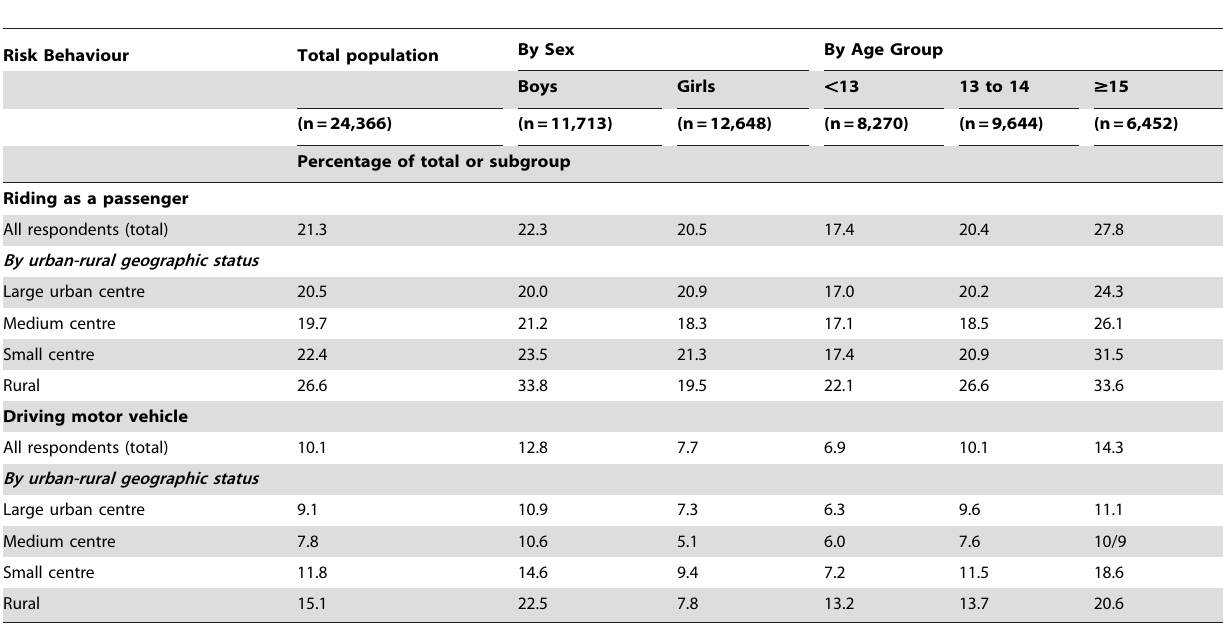
Table 2. Percentage of young adolescents reporting any use of alcohol, marijuana or other illicit drugs by driver while in a car or other motor vehicle, 2010 Canadian HBSC by sex and age group. 1